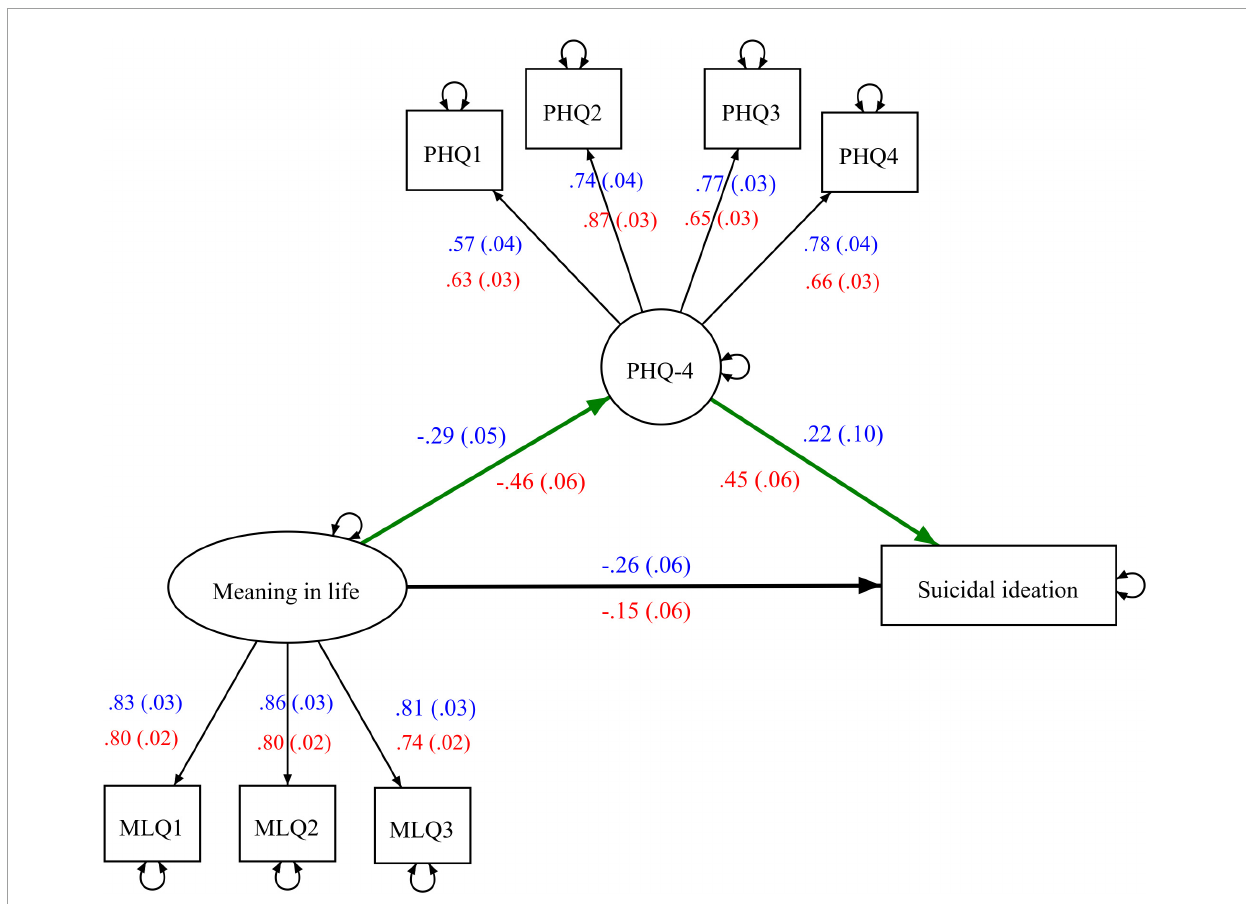
FIGURE1 Path coefficients from meaning in life to suicidal ideation (SI) via PHQ-4 in structural equation model across non-distress and distress groups. PHQ-4, Patient Health Questionnaire-4; the regression paths and factor loadings in the non-distress and distress groups are shown in blue and red, respectively. Regression paths among the latent variables and SI are bolded and the indirect effects from meaning in life to SI via PHQ-4 are highlighted in green.